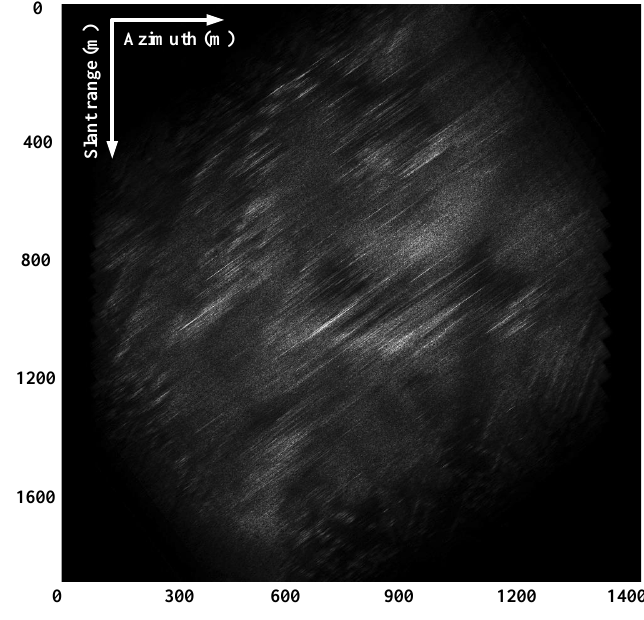
Figure 11. Squint SAR image without motion error